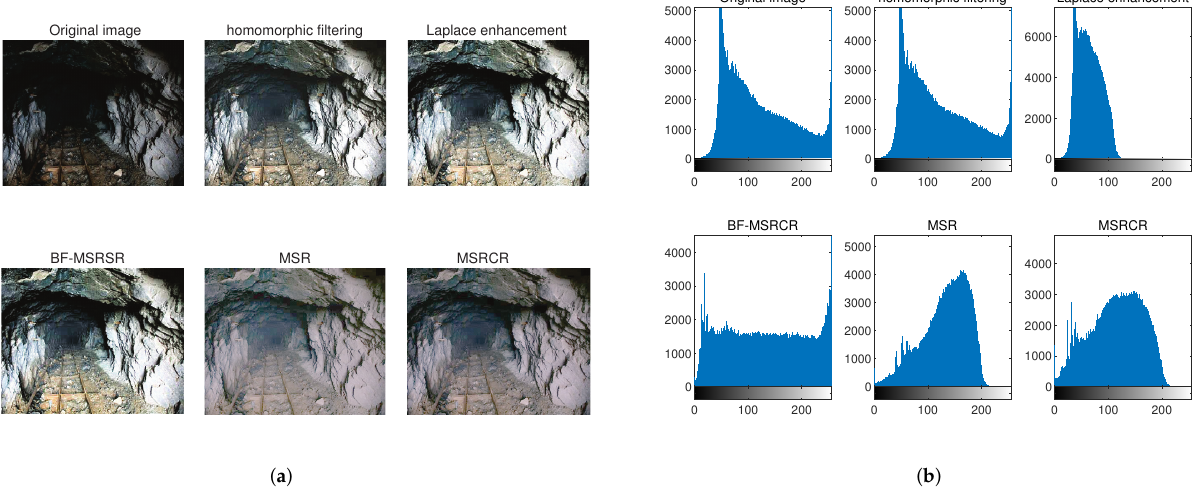
Figure 8. Image 1 algorithm and greyscale histogram comparison. ( a ) Image 1 algorithm comparison; ( b ) Image 1 algorithm and greyscale histogram comparison.